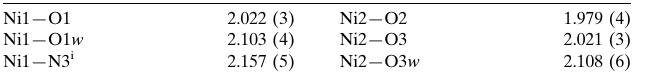
Selected bond lengths (A˚